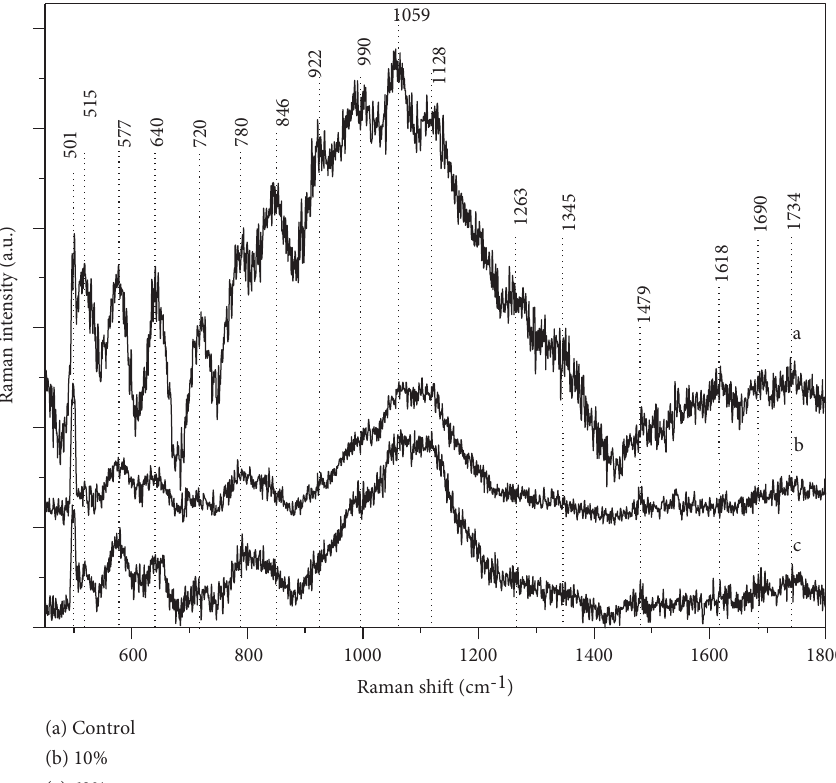
Figure 6: Vibrational information of the chemical bonds of the molecules of the sperm head in Wistar rat in the following groups: (a) control (CN) regular chow, (b) 10% (OW) (c) 60% (OB) lard chow groups. Table 3: Frequencies of the main peaks observed from the sper- matozoa head. Raman peaks (cm − 1